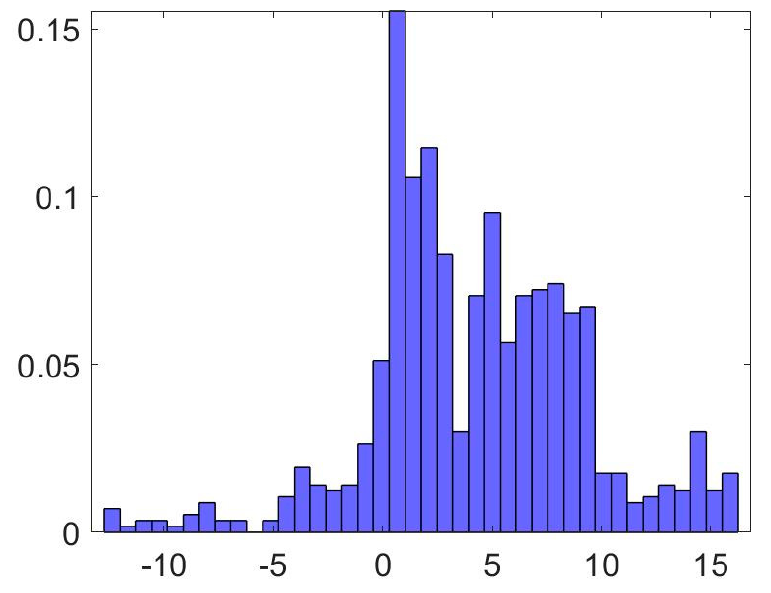
Figure 2. Histogram of housing–price return data. Note: Twelve–month change in percent on horizontal. Relative frequency on vertical axis. Table 1. Descriptive statistics of the returns, Jarque–Bera and unit root test statistic. Mean